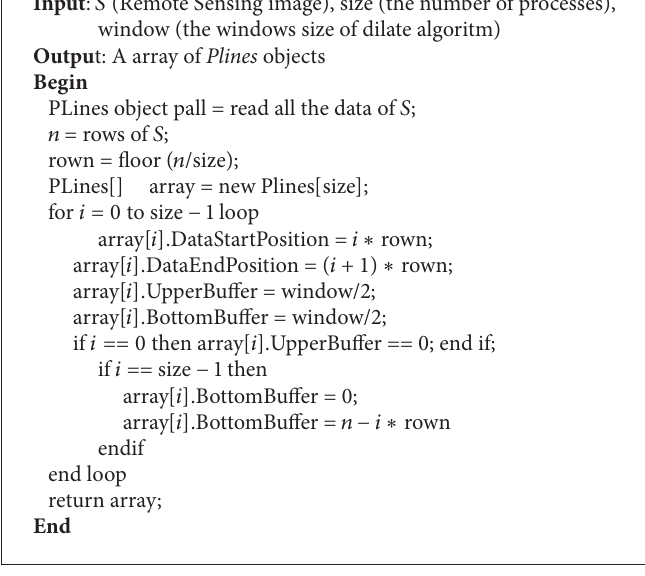
Algorithm 1 Table 1: Run speed in multiprocess and